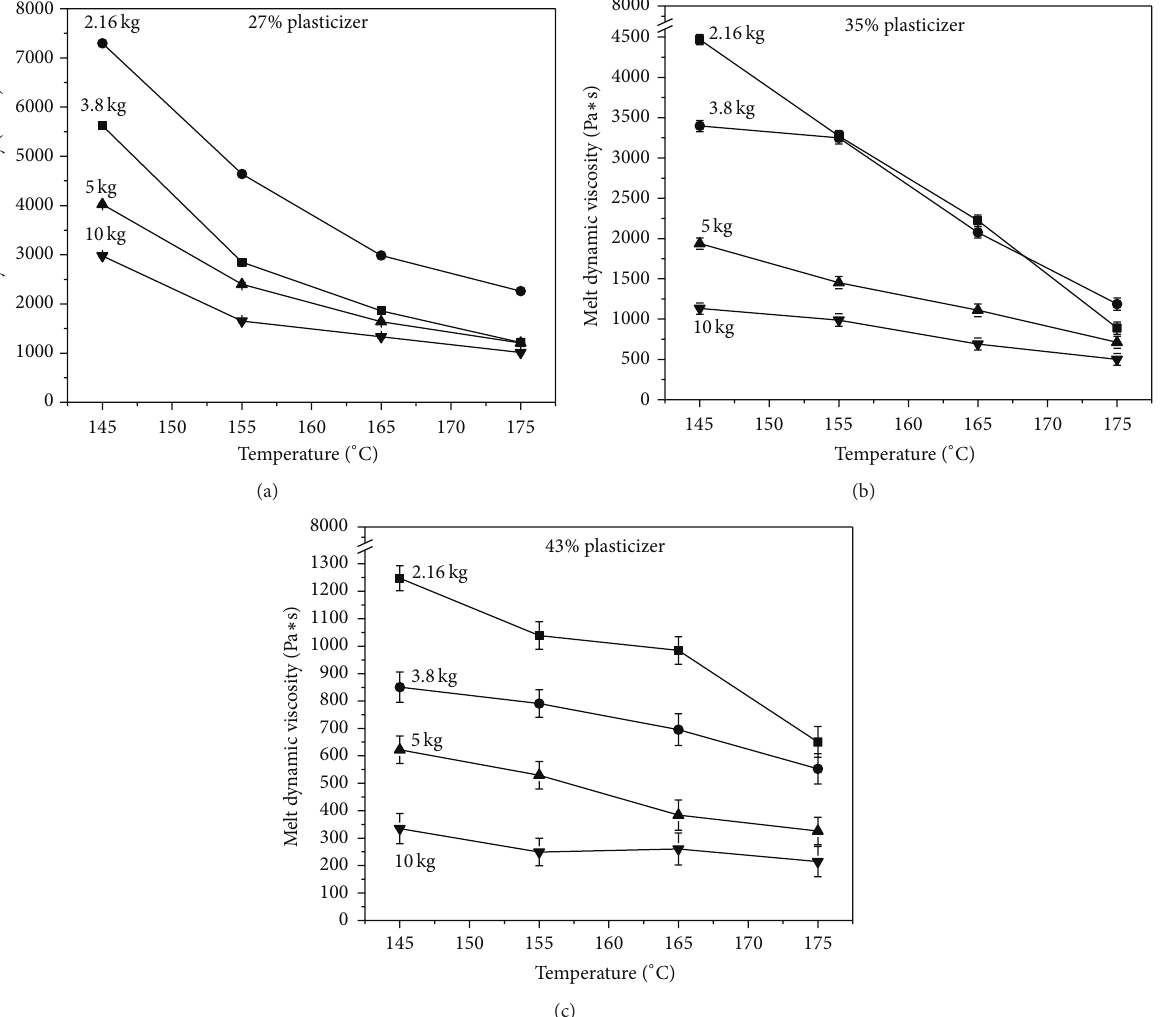
Figure 3: Dynamic viscosity dependence on the extrusion conditions and the plasticizing level ((a) 27%; (b) 35%; (c) 43%).